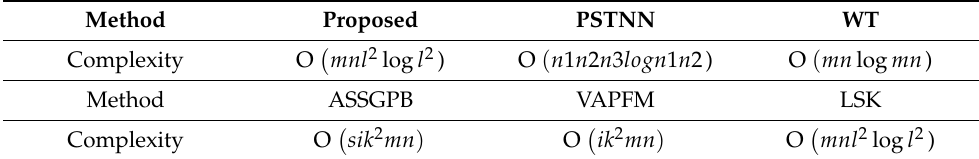
Table 3. Comparison of computational complexity of six methods.